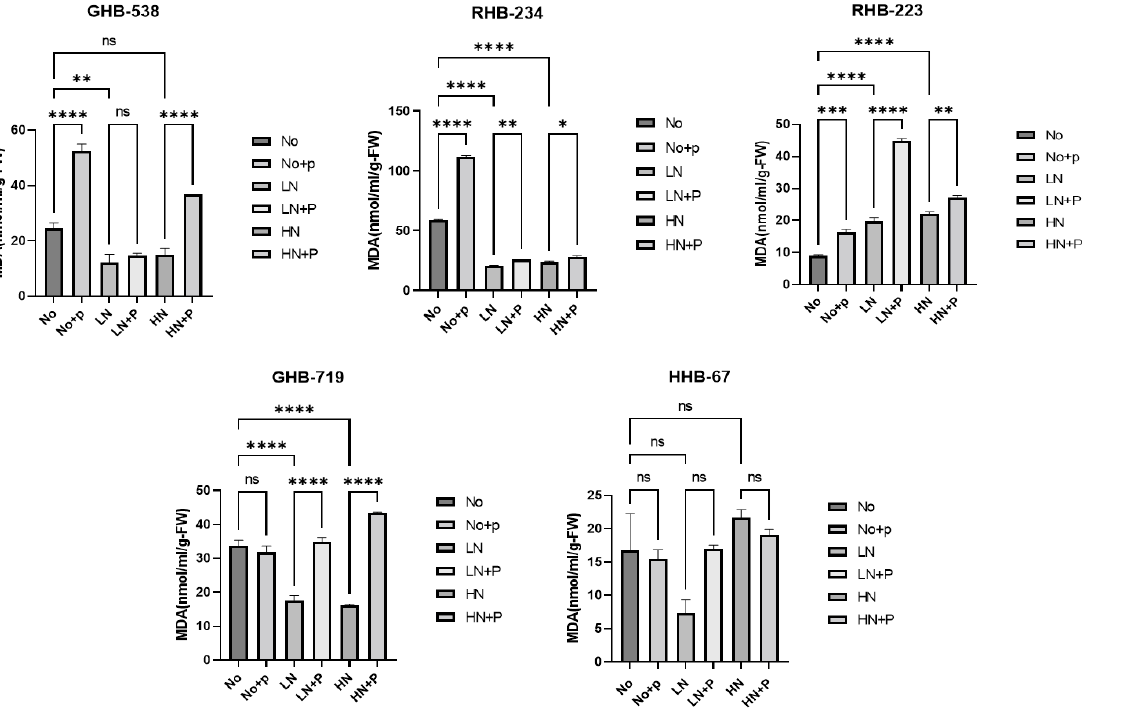
Figure 4. MDA content in the leaf of pearl millet treated with different N and drought stress (PEG- 6000-10%). Bars are means ± standard error (n = 3). In the above bar (****, ***, **, *) represents differences among treatments (Tukey’s test, p ≤ 0.0001), while ns represents no significant difference.